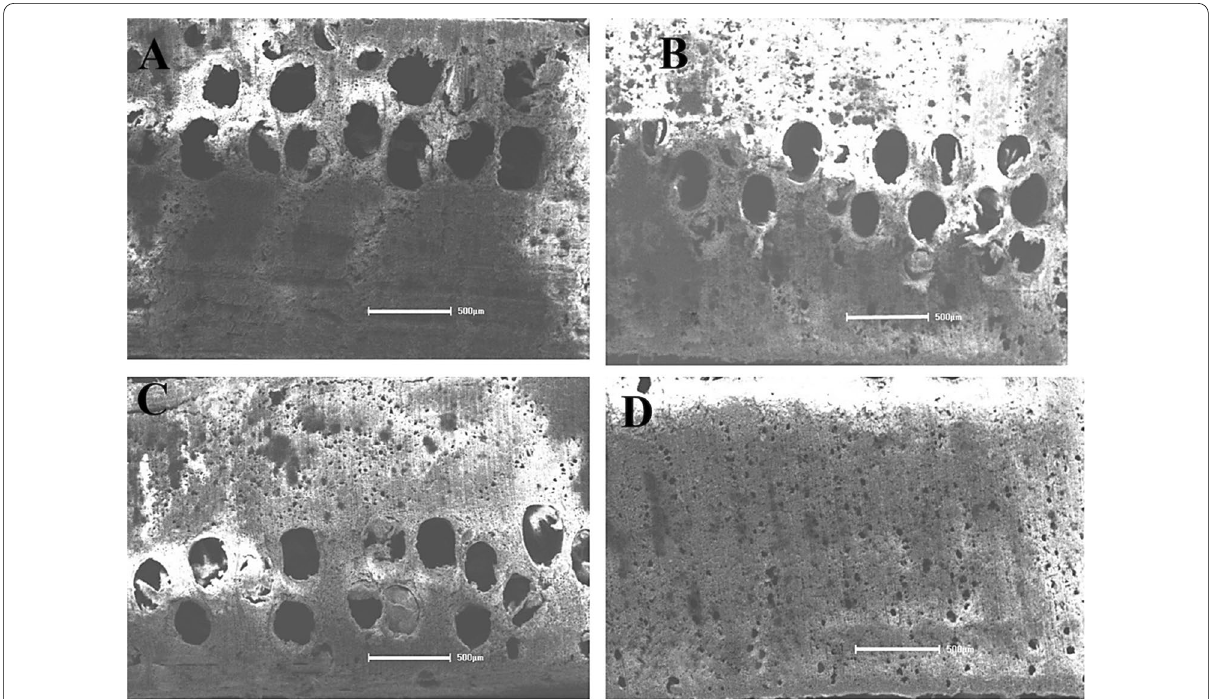
Fig. 3 Anatomy structure of white oak specimens with various distributions of earlywood vessel belt